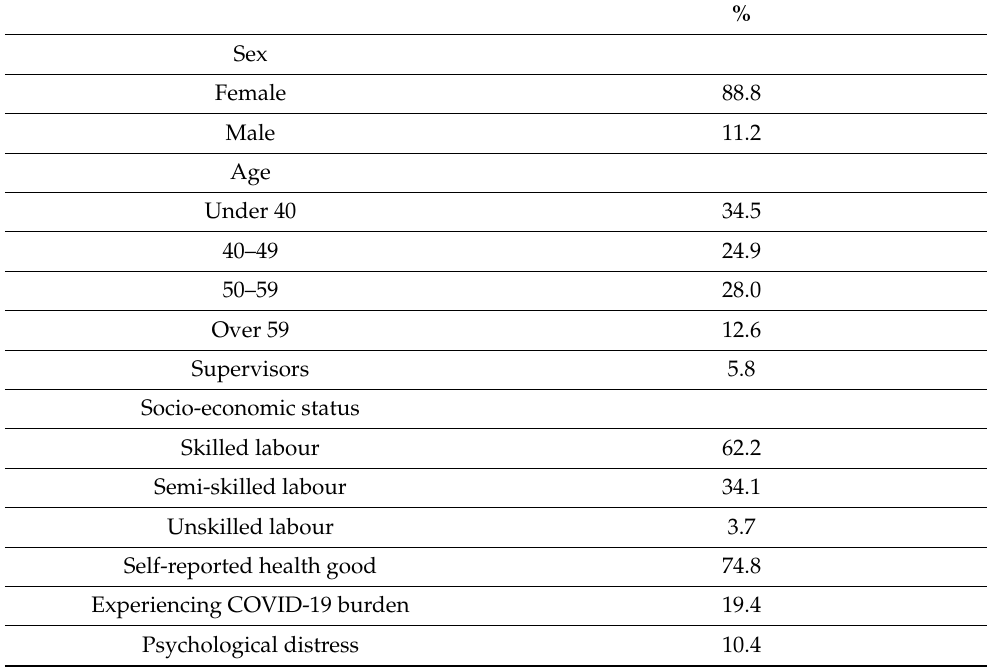
Table 1. Characteristics of the study population (N =